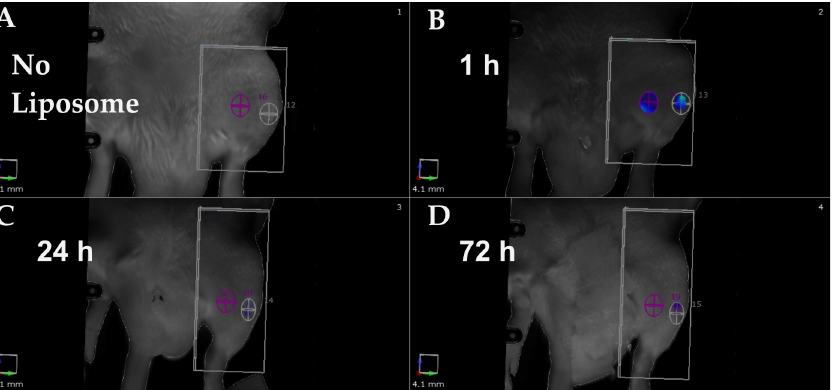
Figure 6. The in vivo imaging of α -MSH-SM-liposome usage in implant inflammation. The imaging was performed before liposome addition and at 1 h, 24 h, and 72 h after it. The panel shows a representative image before fluorescent liposomes were not injected ( A ), post-1 h ( B ), post-24 h ( C ), and post-72 h ( D ) after liposome addition. The ROI was placed at the bone-implantation site with Mg-10Gd (white) and the muscle area (violet/colored) from which fluorescent signals were determined.